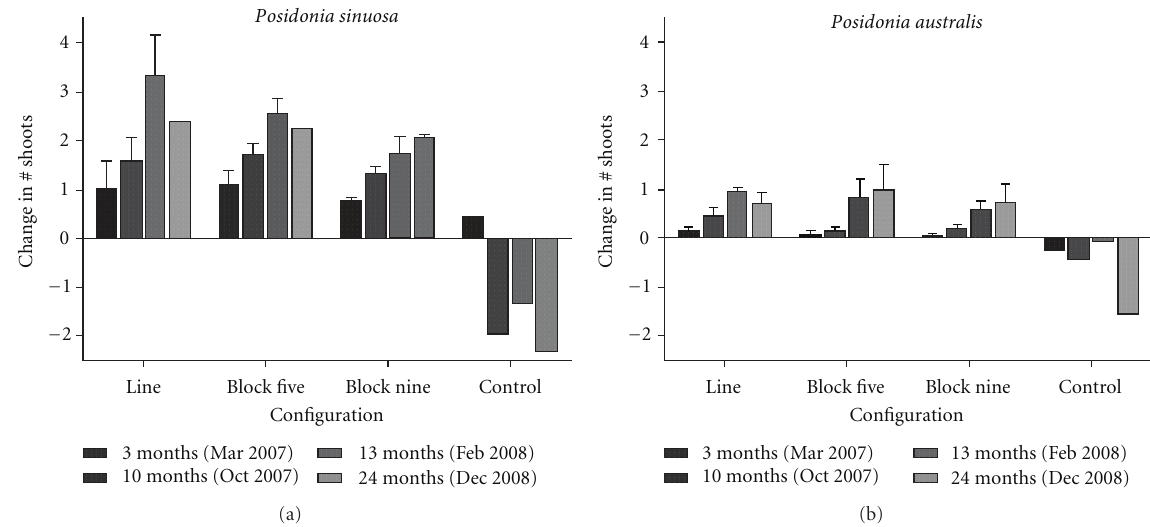
Figure 3: Change in mean number of (a) Posidonia sinuosa shoots and (b) Posidonia australis shoots over 3, 10, 13, and 24 months after plug extraction ( t = 0) in configurations of line, block five, and block nine (mean ± SE, n (replicates) = 4, n (control) = 1).